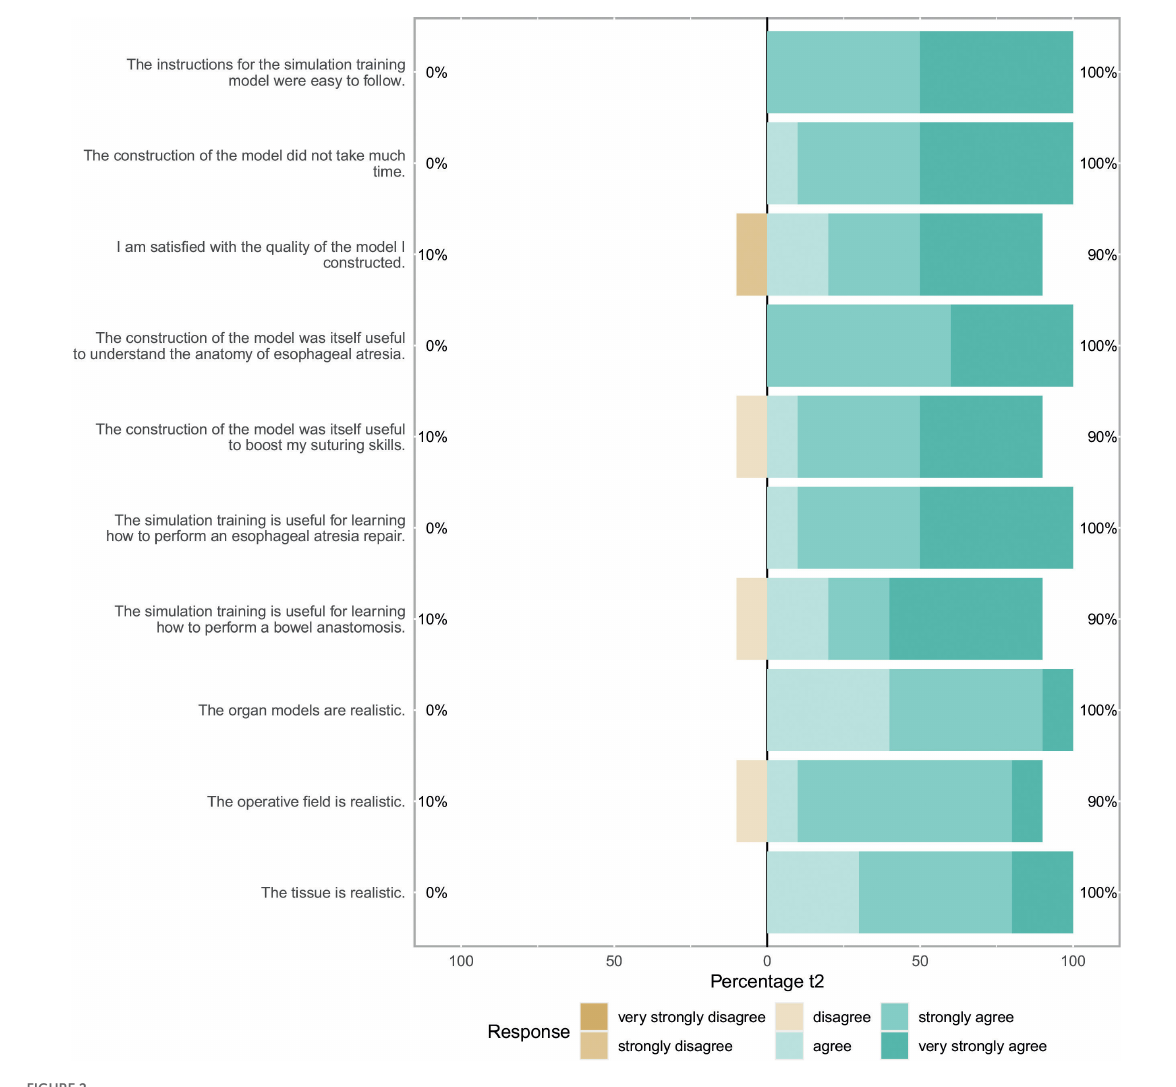
FIGURE2 Self assessment items: This Likert plot for t2 shows ten self-assessment items concerning the themes of model assembly, self-assessment of skill acquisition and model realism after completion of the whole training. The scales show the respective fractions of participant answers to the questionnaire. Percentages on the left side show total amount of disagreement and percentages on the right side total amount of agreement with the respective